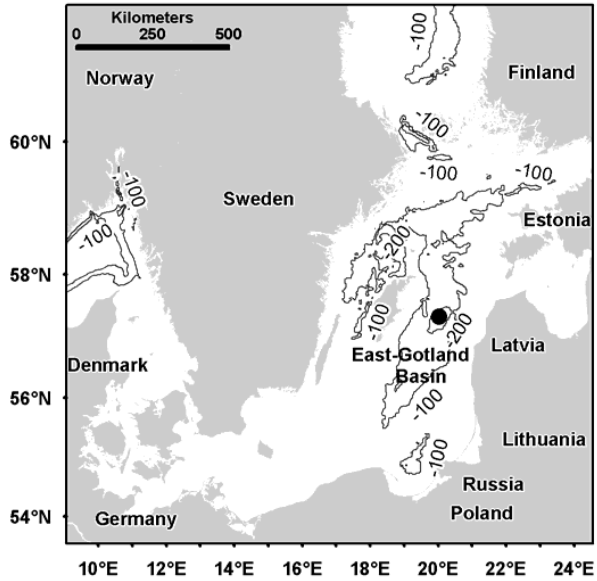
Fig. 1. The Baltic Sea and the location of the Gotland Deep. The study area is indicated with a black dot.